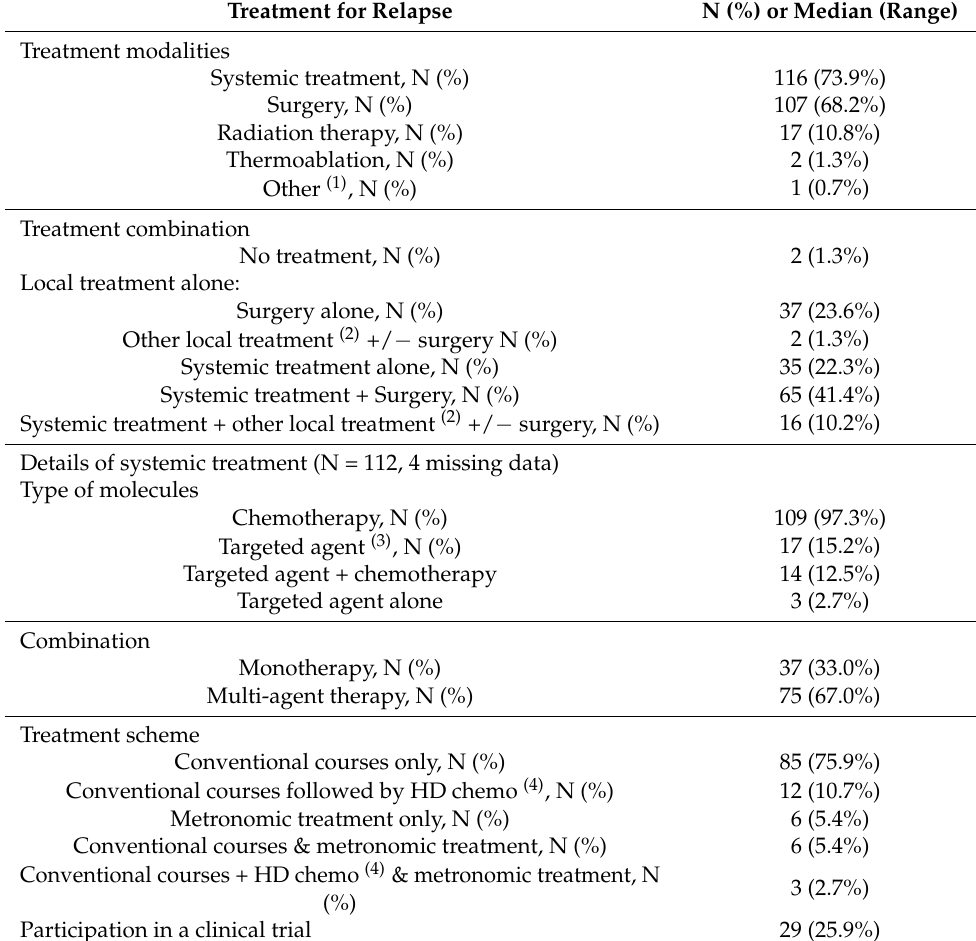
Table 2. Treatment administered for the first